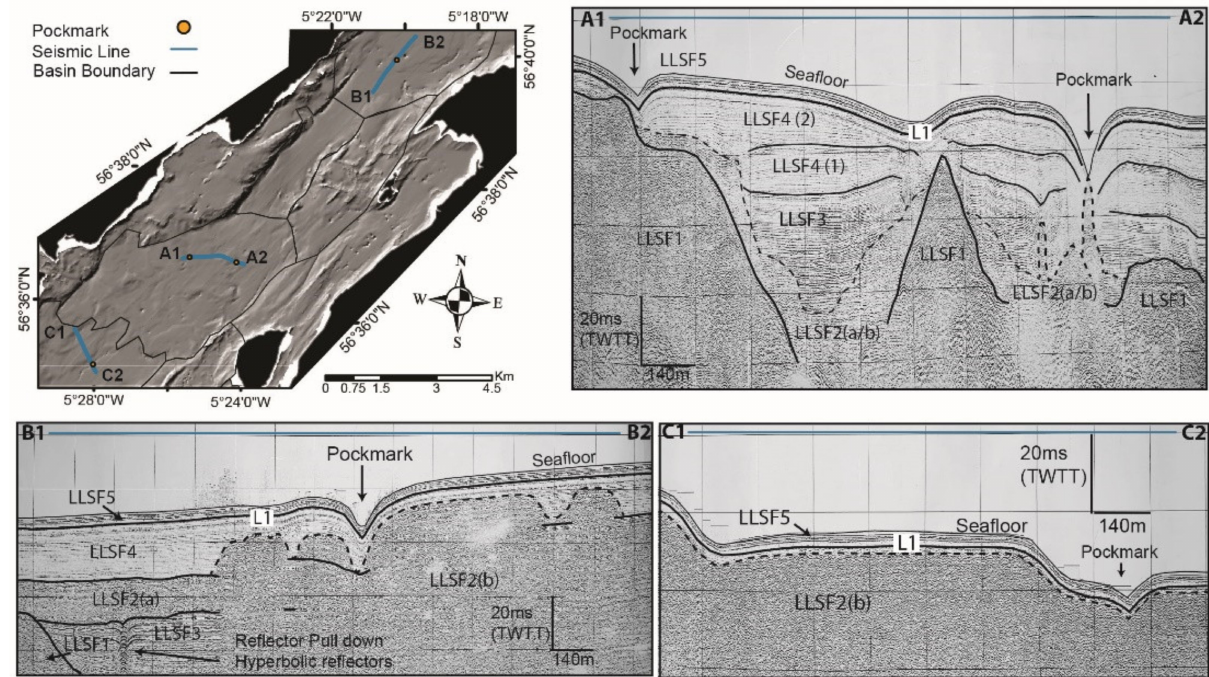
Figure 4. Seismic analysis of selected lines across pockmarks. Map shows the position of seismic lines, basin boundaries and the location of pockmarks that appear on the seismic line. Labelled seismic line sections correspond to the seismic profiles A:C. Profiles B and C are also shown in Figure 4 where gas-associated features are indicated.